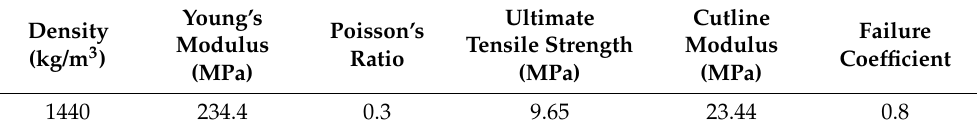
Table 4. Parameters of SPUA.